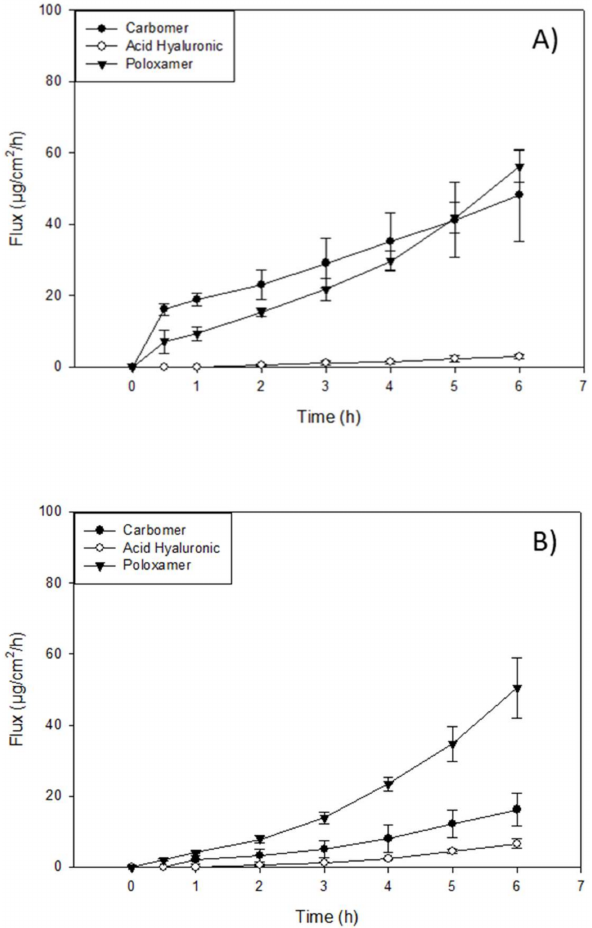
Figure 5. In vitro Franz cell/Strat-M ® permeation profile of resatorvid: ( A ) 2.5% gel formulations and ( B ) 1.25% gel